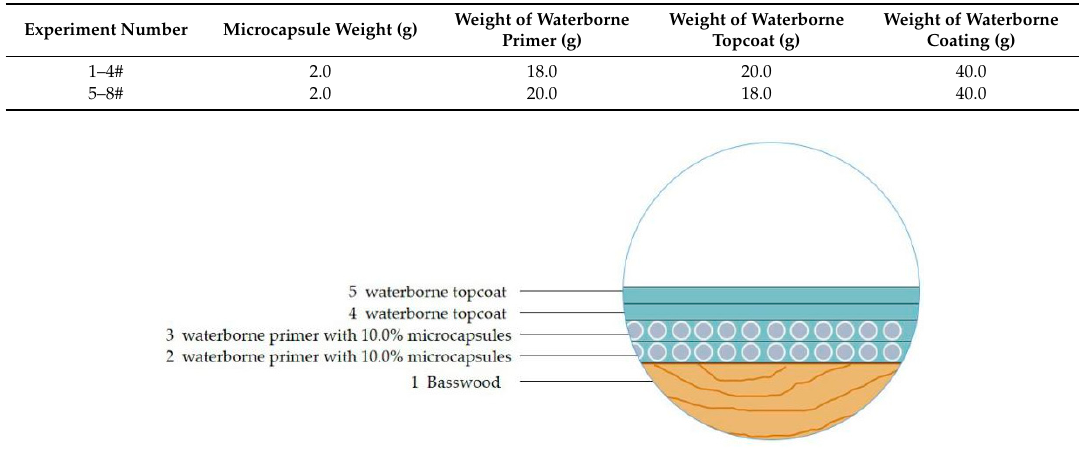
Table 2. Ingredients of the waterborne acrylic coatings with microcapsules.